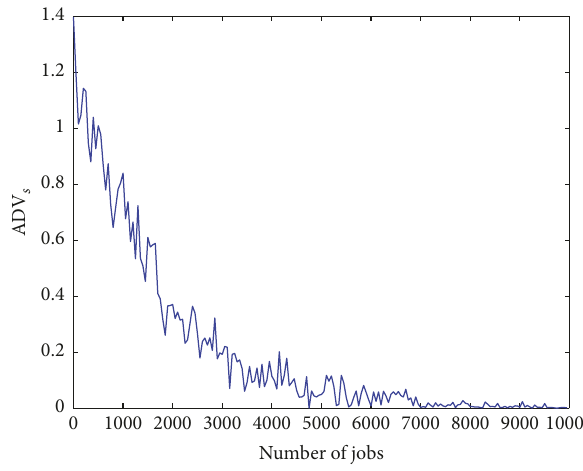
Figure 4: Variation of ADV 𝑠 with respect to the number of finished jobs.